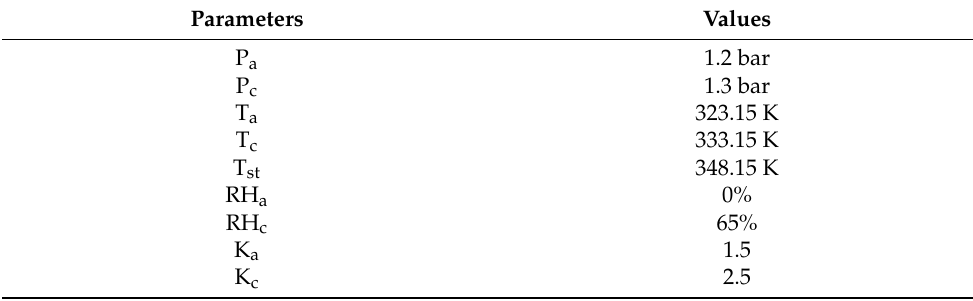
Table 4. HFC voltage-output characteristics test condition